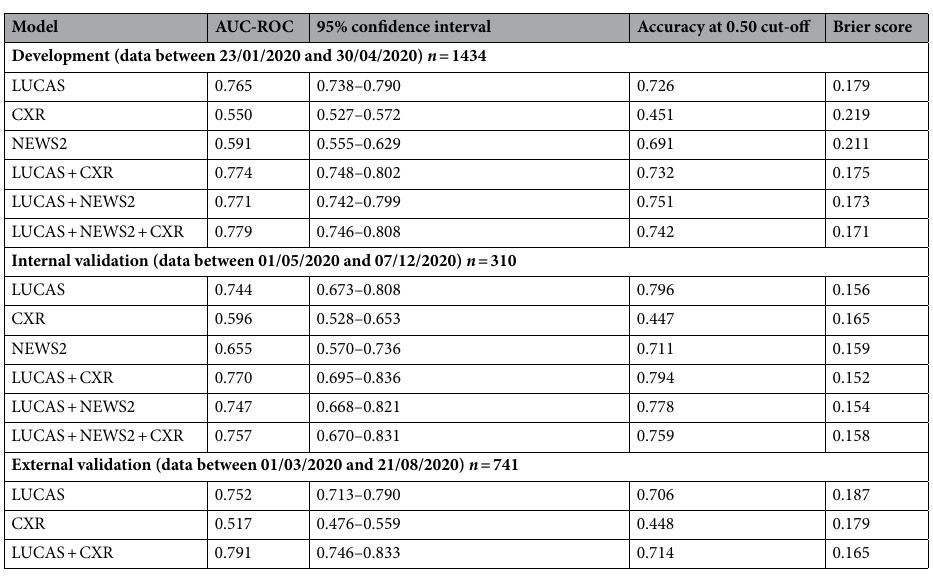
Table 4. Internal and external validation results. LUCAS, model using Lymphocytes, Urea, CRP, Age, and Sex; CXR, chest X-ray severity score; NEWS2, National Early Warning Score